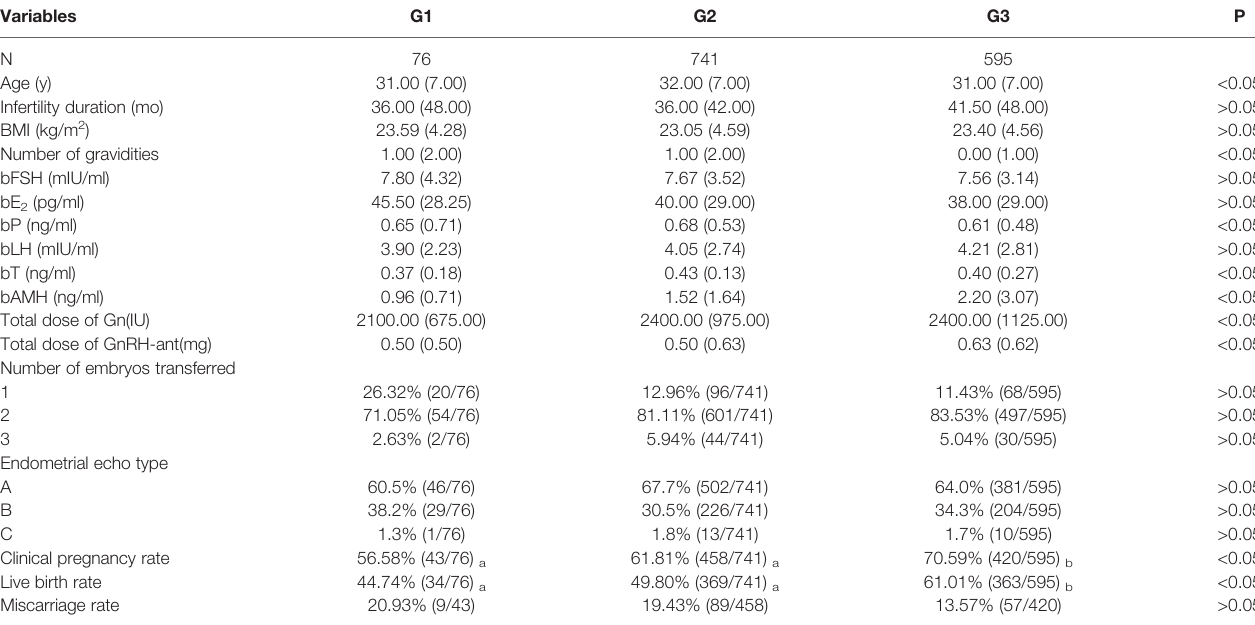
TABLE 4 | Clinical data and pregnancy outcomes in subgroups of GnRH-ant protocol. Variables